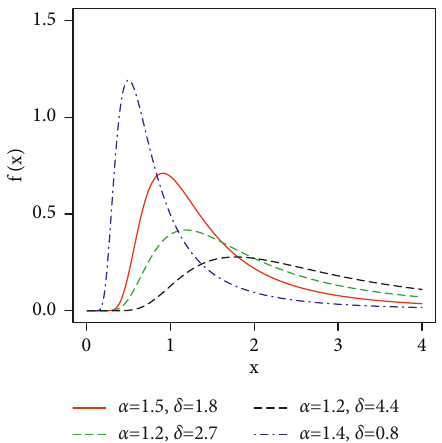
Figure 3: Some possible plots for the PDF of the WTX-IW distribution.